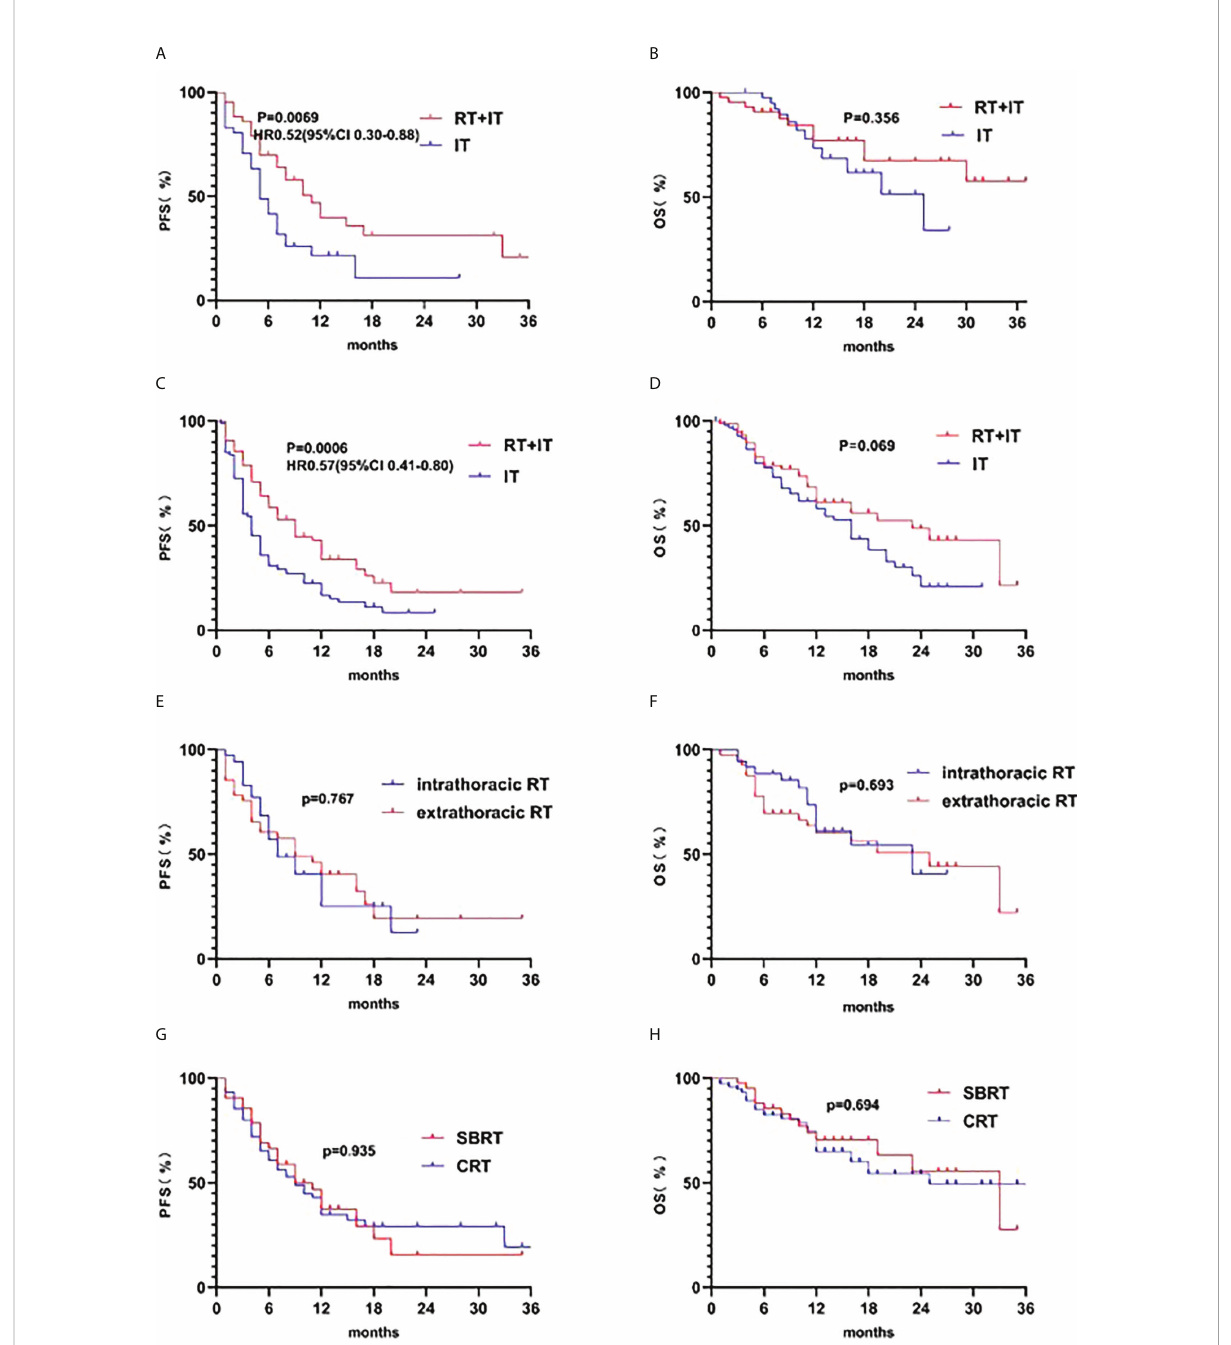
FIGURE 3 Kaplan-Meier survival curves of progression-free survival (PFS) according to (A) radiotherapy plus immunotherapy (RT+IT) (n=43) and immunotherapy (IT) alone (n=41) in stage III patients, (C) RT+IT (n=76) and IT alone (n=99) in stage IV patients, (E) intrathoracic RT(n=35) and extra-thoracic RT(n=41) in stage IV patients, (G) SBRT(n=42) and CRT(n=75) in RT+IT patients. Kaplan-Meier survival curves of overall survival (OS) according to (B) radiotherapy plus immunotherapy (RT+IT) (n=43) and immunotherapy (IT) alone (n=41) in stage IIIpatients, (D) RT+IT (n=76) and IT alone (n=99) in stage IV patients, (F) intrathoracic RT (n=35) and extra-thoracic RT (n=41) in stage IV patients, (H) SBRT (n=42) and CRT (n=75) in RT+IT